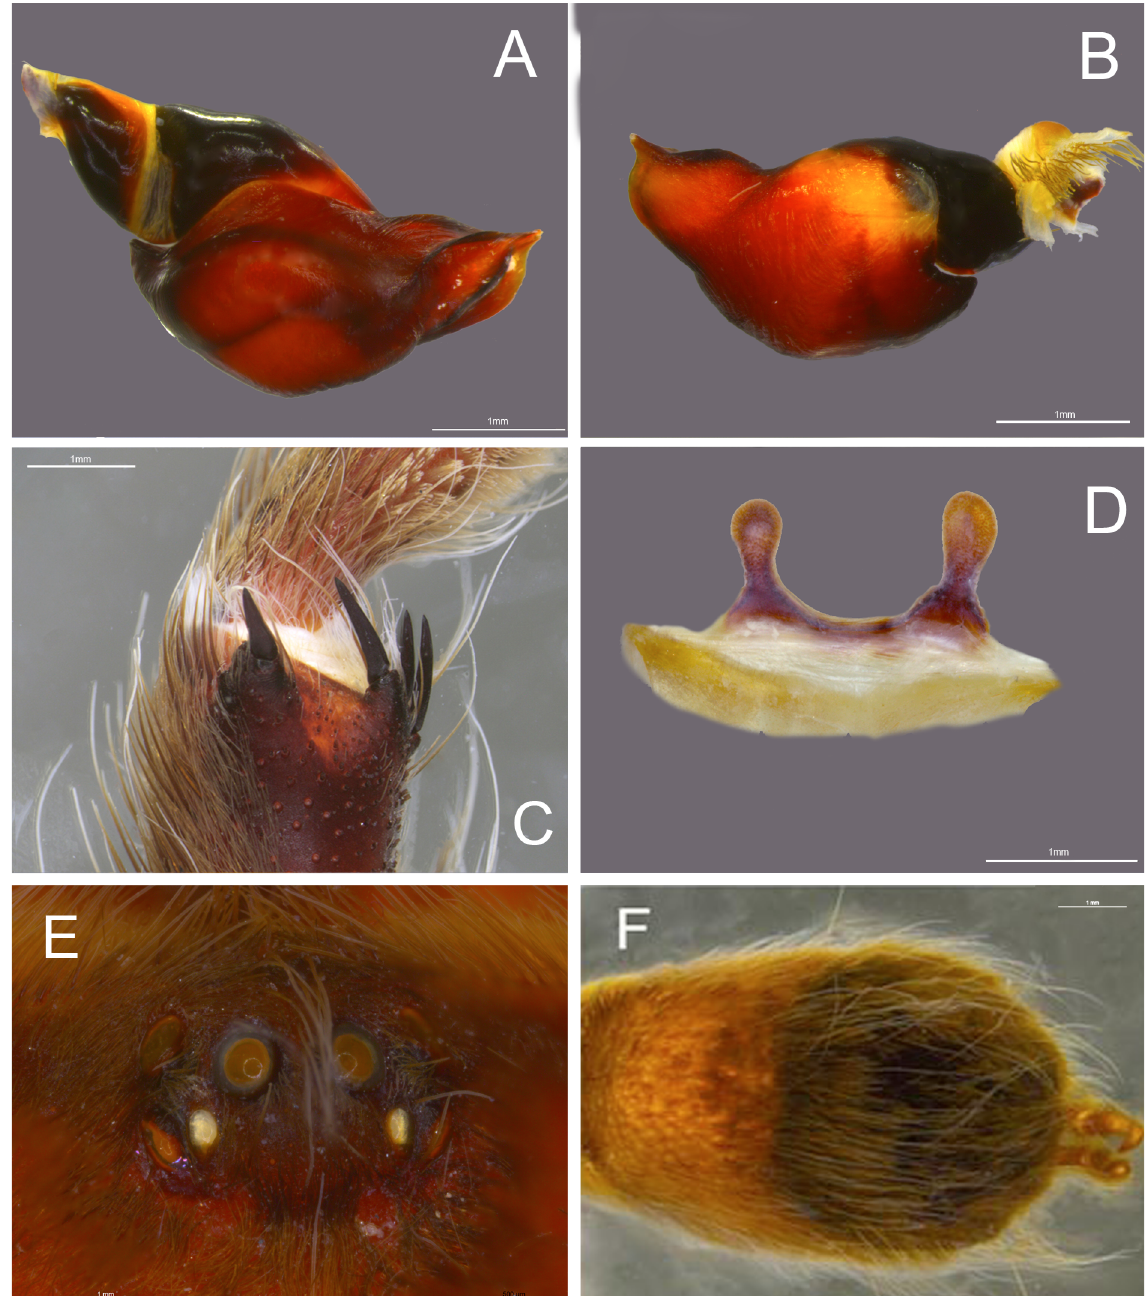
Fig. 16. Umbyquyra cuiaba gen. et sp. nov. A–C . Holotype, ♂, Cuiabá, Mato Grosso, Brasil (IBSP 167423). A . Palp prolateral. B . Retrolateral. C . Tibial apophysis, retrolateral. D–F . Paratype, ♀, Canarana, Mato Grosso, Brazil (IBSP 108933). D . Spermathecae, dorsal. E . Eye tubercle, dorsal. F . Abdomen,